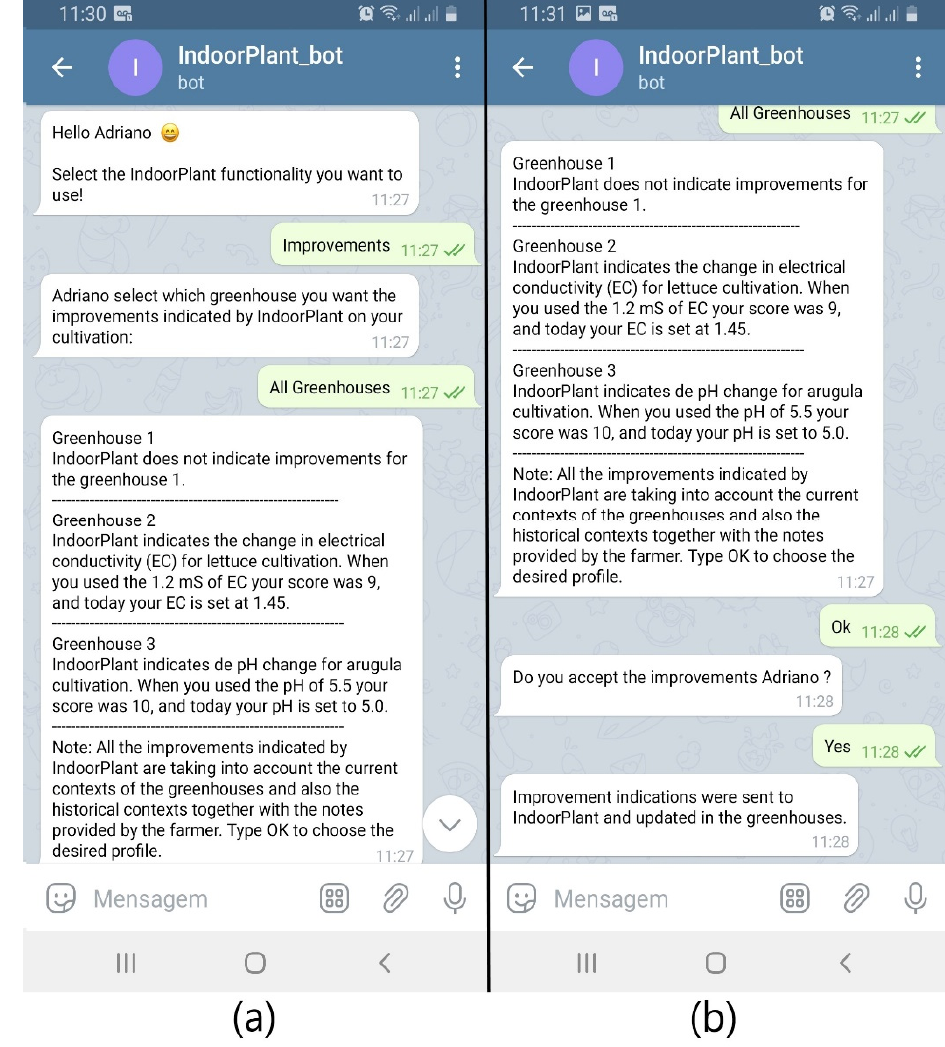
Figure 6. Sample of data sent for the background of historical contexts.